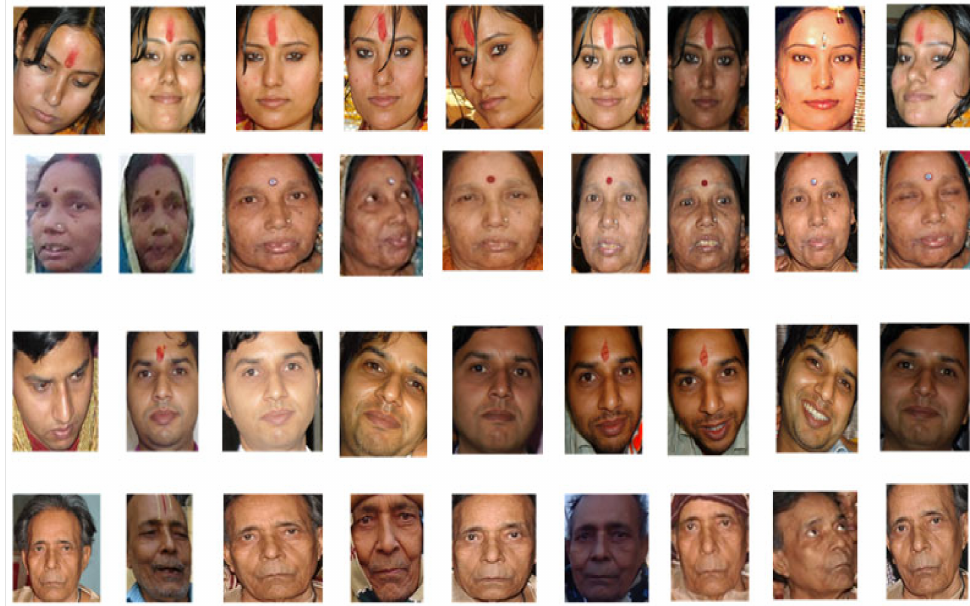
Figure 7. Subgroup of structures reflecting the facts introduced in a video. Exclusive pictorial captured image under different illumination, pose and expressions from same occasion where some frames prove to be convenient for profile identification; other may be harmful to